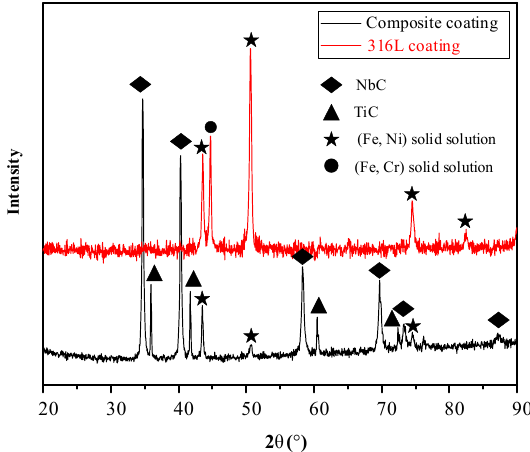
Figure 2. XRD results of 316L coating and composite coating.